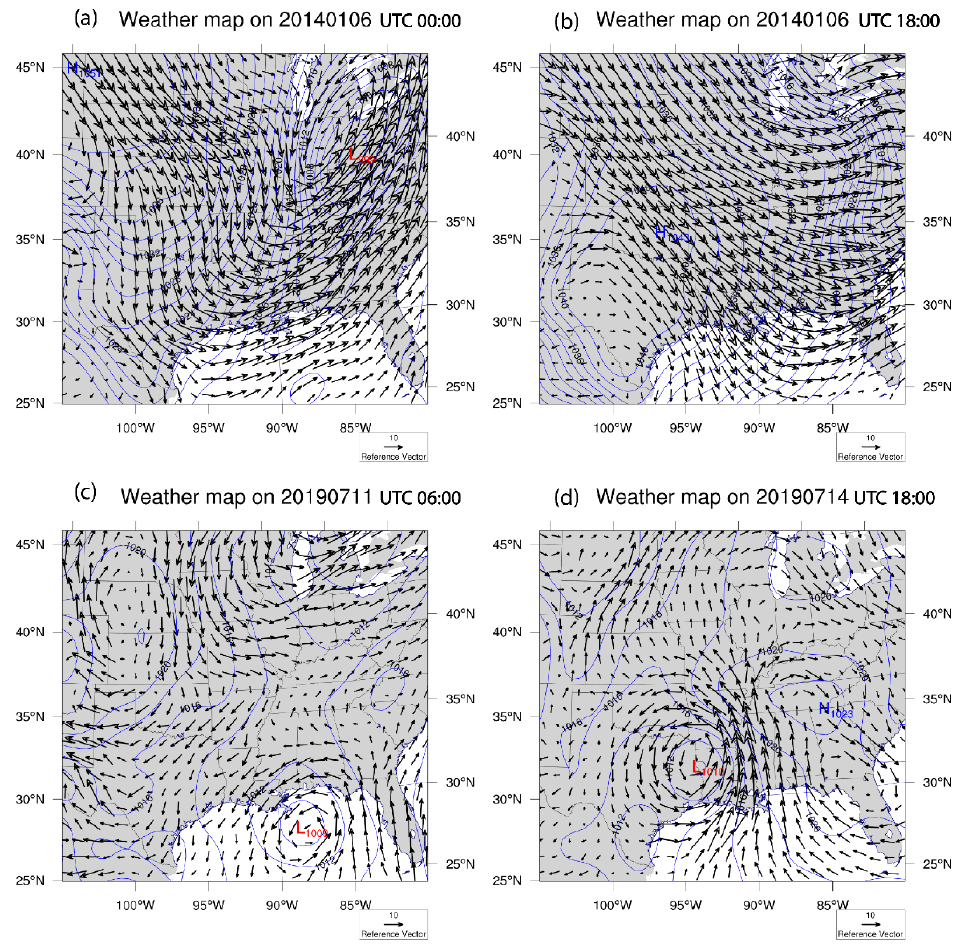
Figure 3. Weather maps during the cold front at 0000 UTC, 01/06 and 1800 UTC, 01/06, and during Hurricane Barry at 0600, 07/11 and 1800, 07/14. ( a , b ) are the weather maps before and after the cold front passage in January 2014, and ( c , d ) are weather maps before and after the landfall of Hurricane Barry. Blue lines are contours of air pressure.